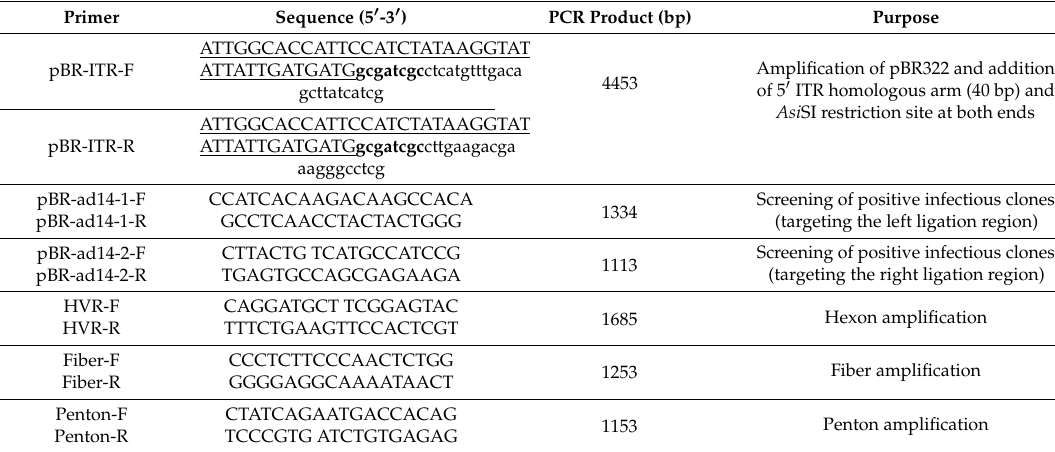
Table 1. Primers used in the